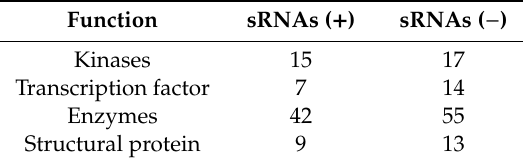
Table 1. Molecular function of sRNA target